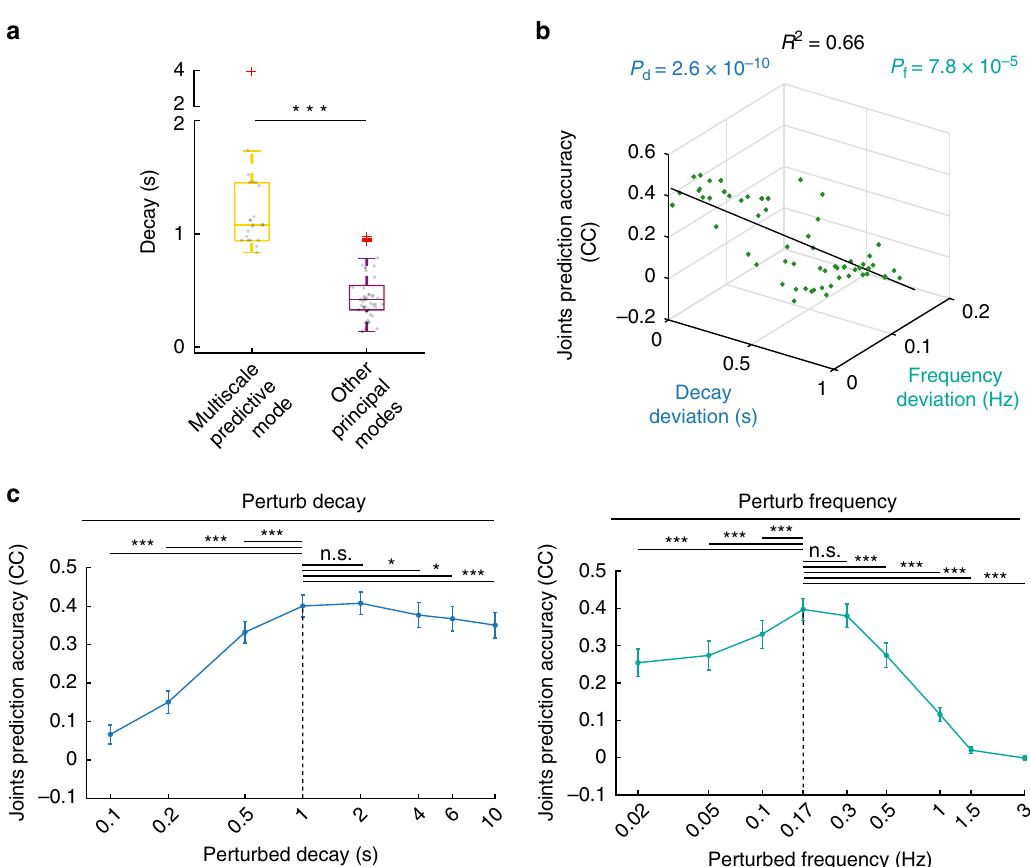
Fig. 8 The multiscale predictive mode had a larger decay than other modes and both its decay and frequency explained naturalistic behavior prediction. a Multiscale predictive modes in Fig. 5 had signi fi cantly larger decays than other complex-conjugate modes in spiking and LFP activity ( P = 9.1 × 10 − 11 , N s > 22 spiking and LFP sessions, one-sided Wilcoxon rank sum test). Figure convention for boxplot and signi fi cance (asterisks) is similar to Figs. 3 and 4. Each grey dot shows the decay of one principal mode across subjects and experimental sessions. b Multivariate linear regression (MVLR) relating the principal mode ’ s prediction accuracy to its decay and frequency deviation. The deviations were computed as the mode ’ s decay and frequency absolute difference from those of the multiscale predictive mode (Methods). Both decay and frequency had signi fi cantly negative coef fi cient with p values reported by P d and P f , respectively ( N s = 66 complex-conjugate principal modes, two-sided paired t test). R 2 shows the R-squared of the fi tted MVLR model. Each green dot represents one complex-conjugate principal mode across subjects and experimental sessions. The black line shows the MVLR fi tted line. c Perturbing decay (left) and frequency (right) of the multiscale predictive modes in the learned state-space model shows that both decay and frequency components explained naturalistic behavior prediction accuracy. Each dot represents the mean prediction accuracy of one perturbed mode across experimental sessions and monkeys; error bars represent 95% con fi dence bounds of the mean. The x axis is shown in log scale and represents the value of perturbed decay and frequency. Asterisks show whether the prediction of the perturbed mode is signi fi cantly different from that of the unperturbed multiscale predictive mode represented by a vertical dashed line, with conventions similar to Fig. 3 (n.s. is non-signi fi cant P > 0.05). Decays ~1 − 2 s had the best prediction accuracy (picked as the interval that had non-signi fi cant difference with the unperturbed mode, P = 4.1 × 10 − 2 , N s = 55 cross- validation folds, one-sided Wilcoxon signed-rank test, FDR-corrected). Also, mode frequencies ~0.17 − 0.3 Hz had the best prediction accuracy (picked as the interval that had non-signi fi cant difference compared with the unperturbed mode, P = 8.2 × 10 − 5 , N s = 55 cross-validation folds, one-sided Wilcoxon signed-rank test, FDR-corrected). Source data are provided as a Source Data fi